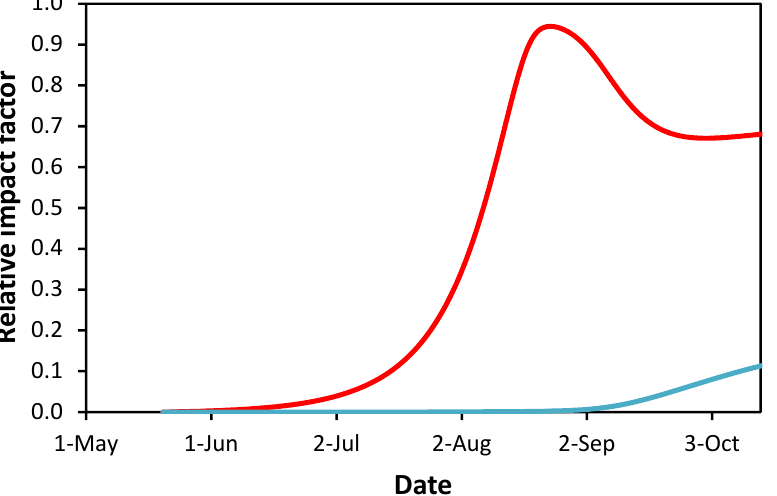
Figure 3. Relative impact of the two species on each other based on Figure 2. Blue line: impact of C. ohridella on G. aesculi. Red line: impact of G. aesculi on C. ohridella.